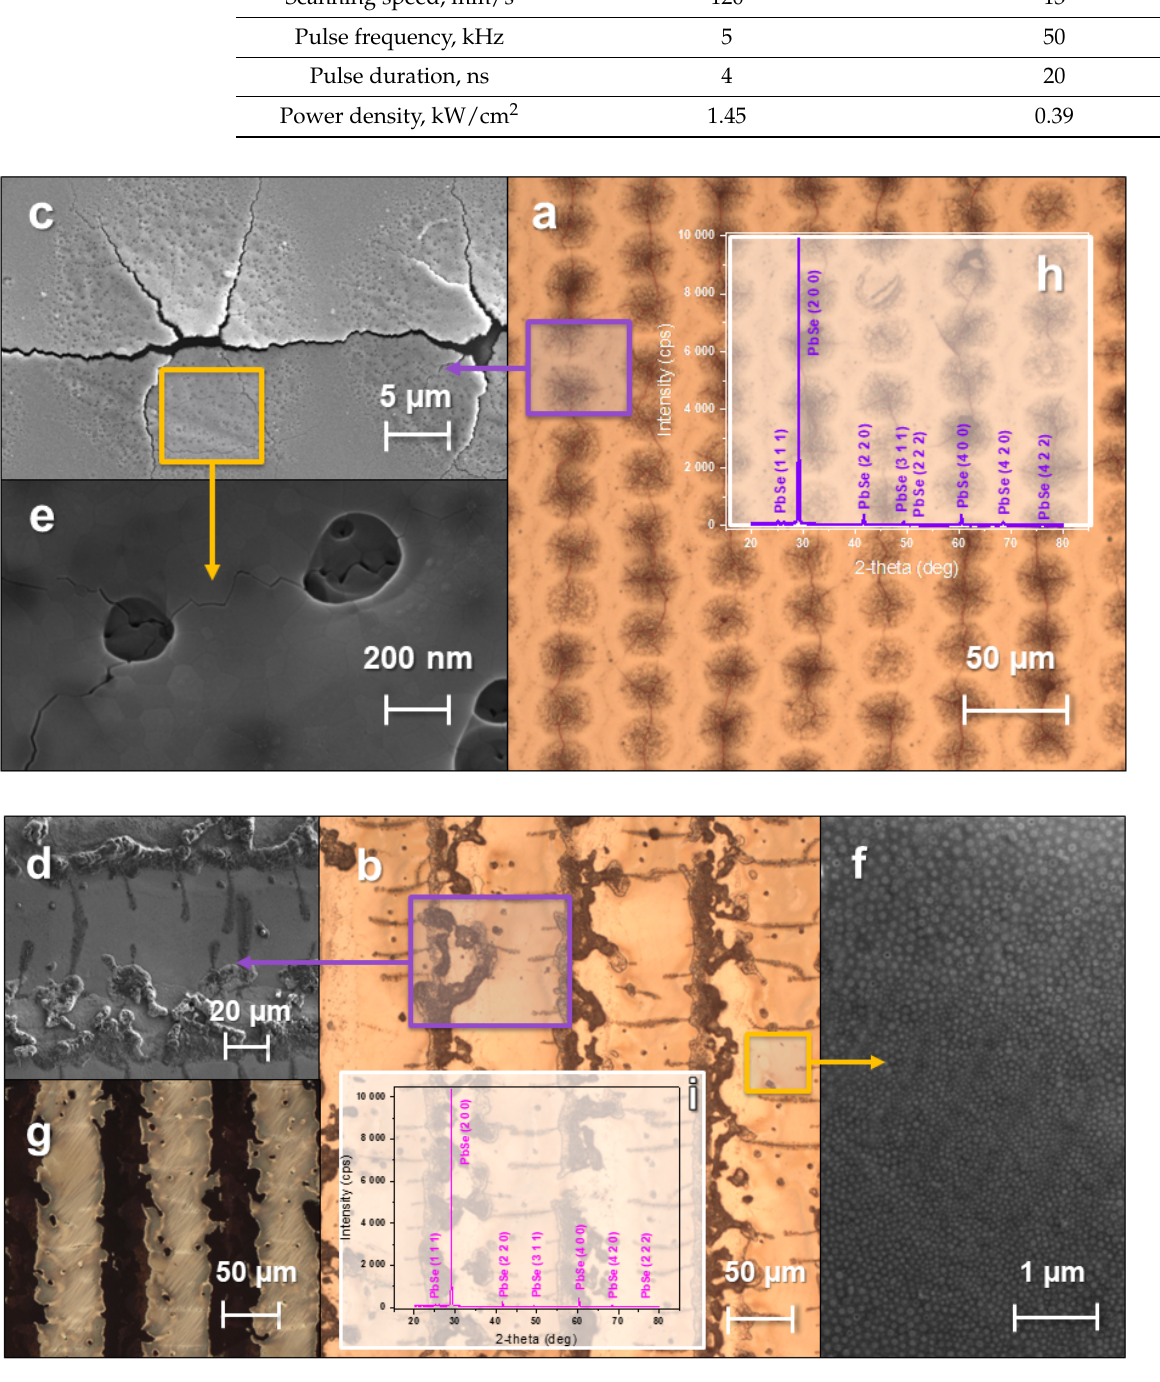
Figure 4. Images of a PbSe film obtained using optical microscopy: in a bright field of reflected light, ( a ) darkening mode when modified by pulsed radiation, ( b ) bleaching mode when modified by pulsed radiation; in the transmitted light field ( g ), the bleaching regime upon modification by pulsed radiation. Pictures of the PbSe film obtained with the SEM secondary electron detector: ( c , e ) darkening mode when modified by pulsed radiation, ( d , f ) bleaching mode when modified by pulsed radiation. Pictures of the PbSe film obtained using an X-ray diffractometer: ( h ) darkening mode when modified by pulsed radiation, ( i ) bleaching mode when modified by pulsed radiation.